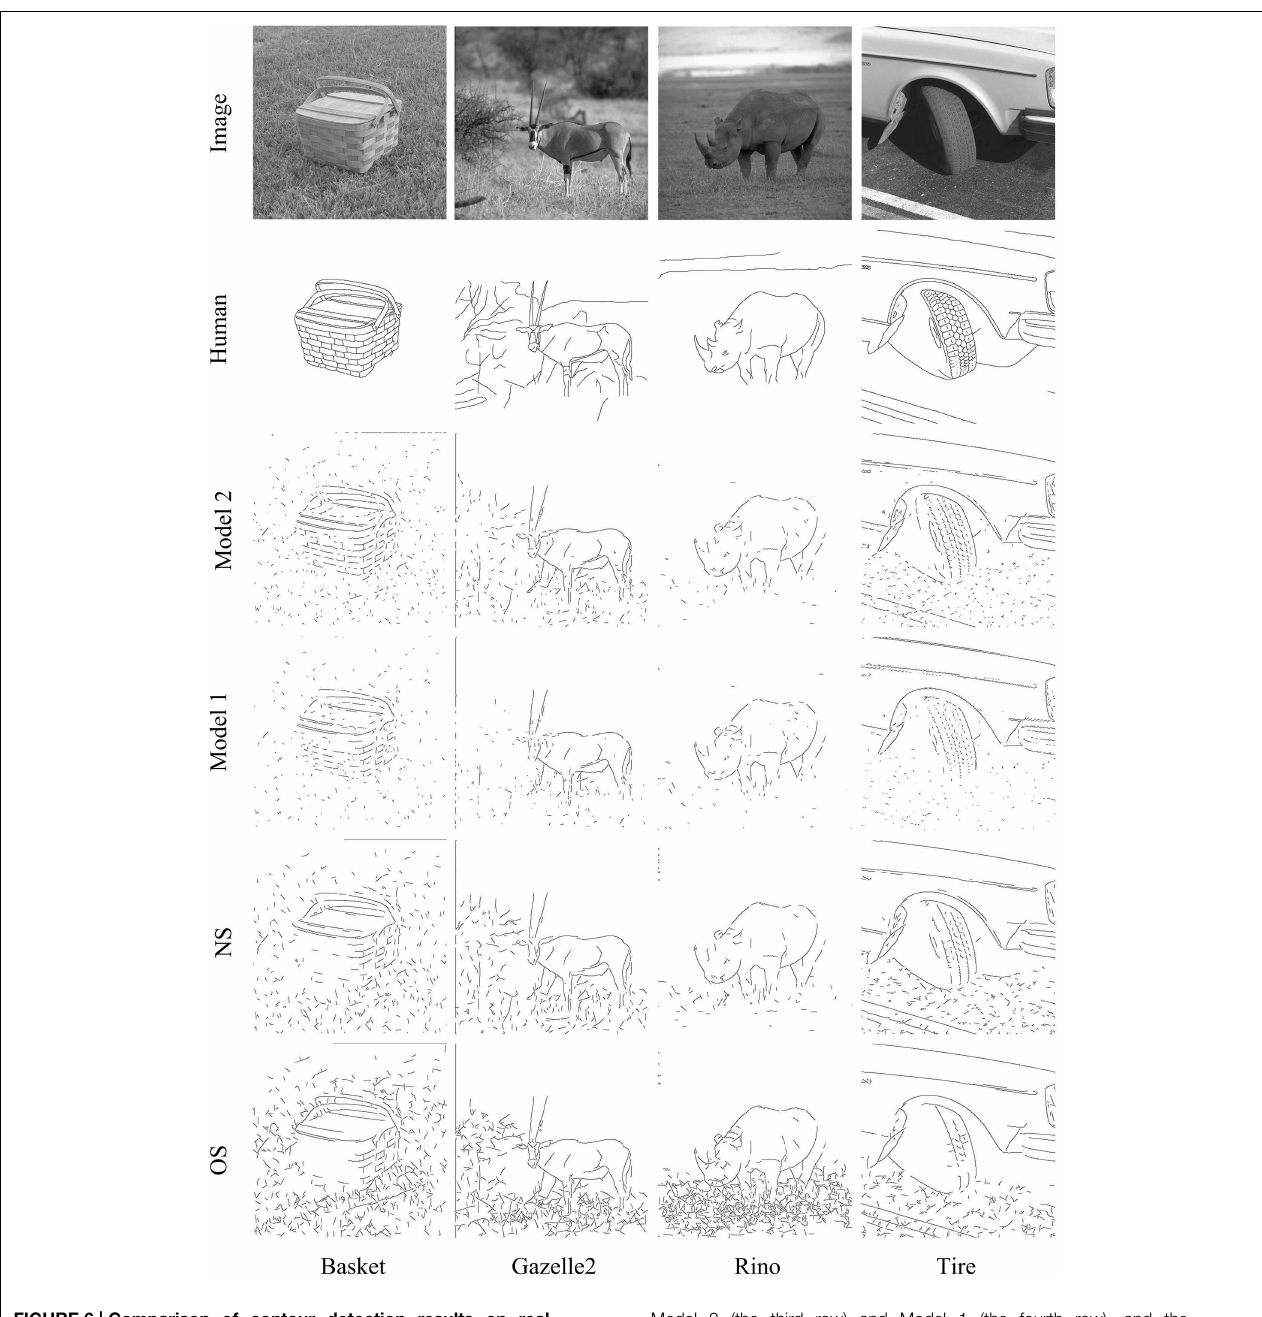
Model 2 (the third row) and Model 1 (the fourth row), and the best contour maps obtained with non-selective (denoted by NS) (the fifth row) and orientation-selective (denoted by OS) (the last row) inhibition